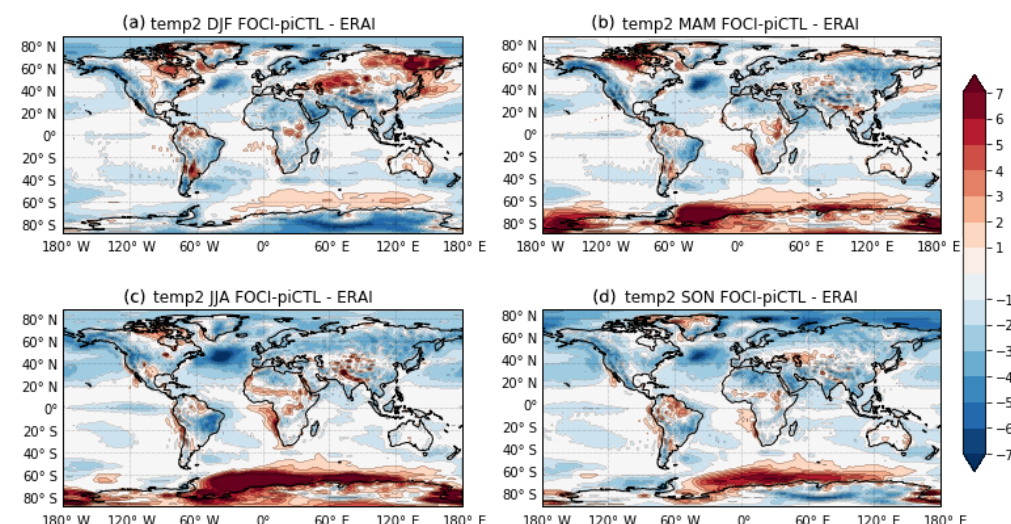
Figure A1. Seasonal mean SAT bias – (a) DJF, (b) MAM, (c) JJA and (d) SON – with respect to ERA-Interim (1979–2017).